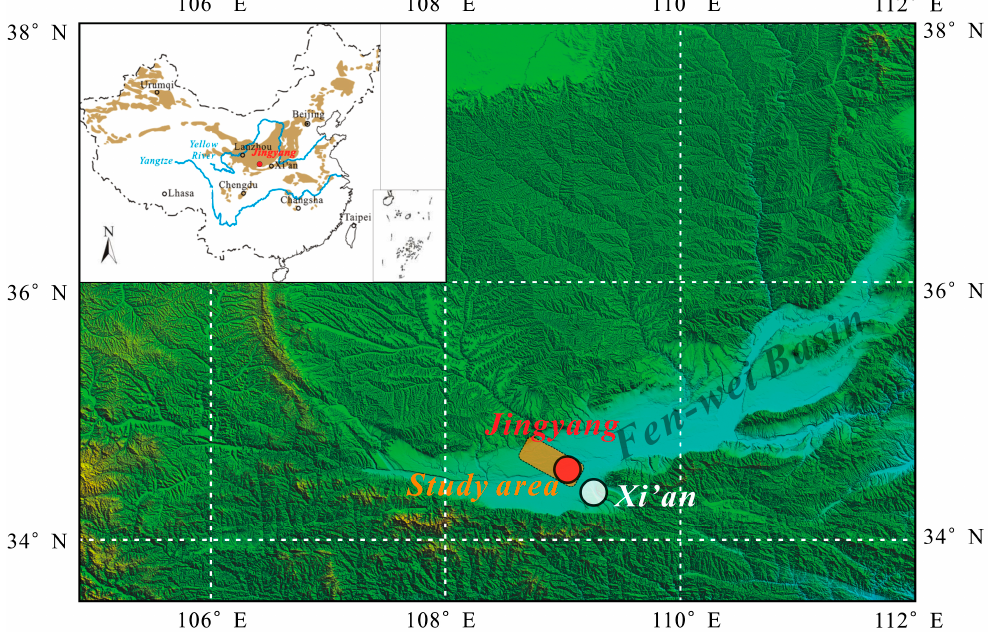
Figure 1. Study location of the South Jingyang Plateau in the northwestern of China.